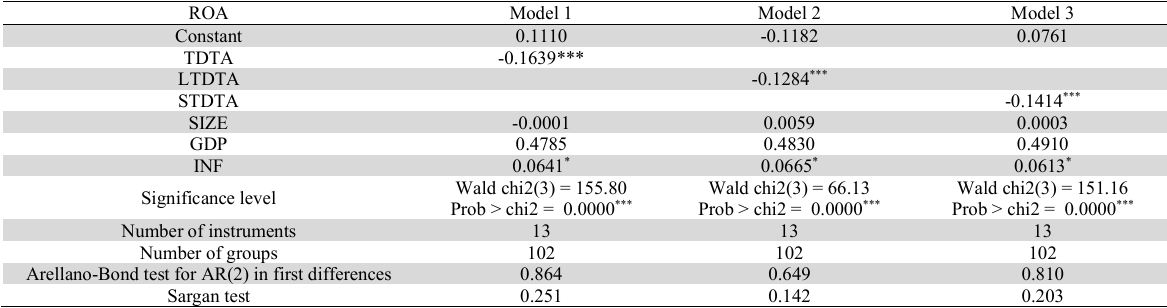
Estimated results using